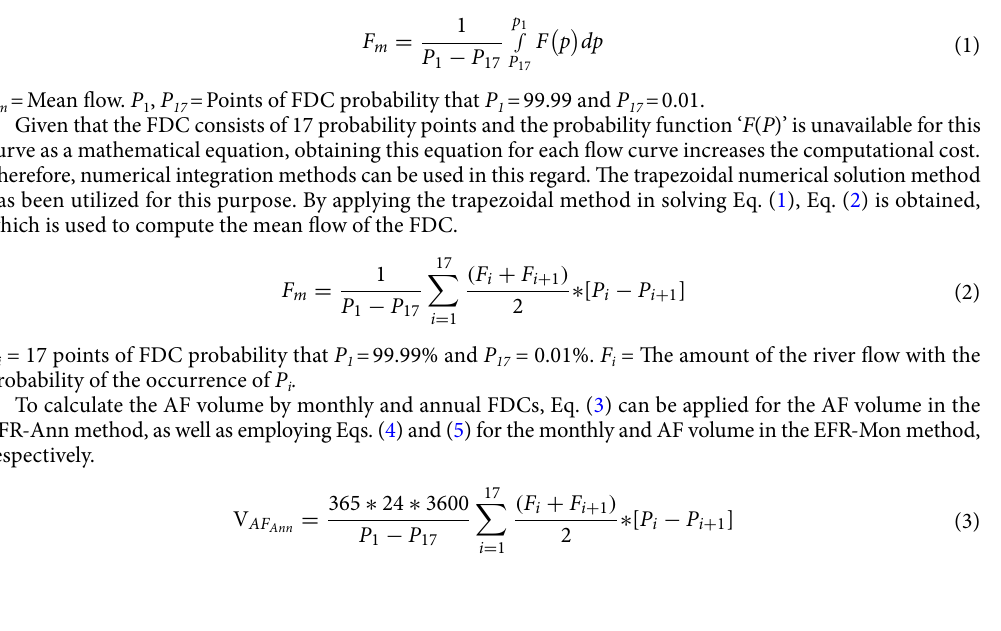
Fig. 2 shows the distribution of the Nazlu River flows in the west of Urmia Lake throughout the year. According to the data, 74% of the AF crosses the river from March to June, and the highest and lowest river discharges are related to May with 29% and September and August with 2% of the AF, respectively. According to the flow distribution throughout the year, the annual FDC is an average FDC of each month of the year. However, the flow of a river during the months of the year represents significant changes. Therefore, the monthly FDC is higher than the annual FDC in the high-water months (e.g., May). Additionally, this curve is lower compared to the annual FDC in the low-water months (e.g., September). Accordingly, the use of monthly FDCs provides more details of changes in the hydrological parameters of the flow and can be a better indicator of the hydrological index of river flows. In the conventional FDCS method, the FDC is obtained using the MMF data of each station. The obtained curve represents the monthly average of river flow and does not illustrates the minimum, maximum and the effect of flow fluctuations in the estimation of e-flows (Fig. 2). In the new methods, all FDC diagrams were obtained by daily data. Both annual (EFR-Ann) and monthly (EFR-Mon) methods are separately utilized to compare the calculation of the e-flow and to choose the best method. The annual FDC is a probabilistic chart for the whole year and the monthly FDC includes 12 prob- ability curves for each year. Due to the use of FDC in e-flow estimations, it has been attempted to perform all calculations from this diagram. Therefore, concepts related to the flow volume can be integrated with the FDCS method. Some of the applied concepts for this purpose are as follows. In the FDCS method, the FDC is defined based on 17 probabilistic percentage points. To calculate the mean AF (MAF) volume, the theorem of the mean value for a definite integral is employed in the FDC diagram. Accordingly, considering that FDC is continuous between the first and seventeenth probability points, the mean flow ( F m ) is obtained from Eq. (1) as.